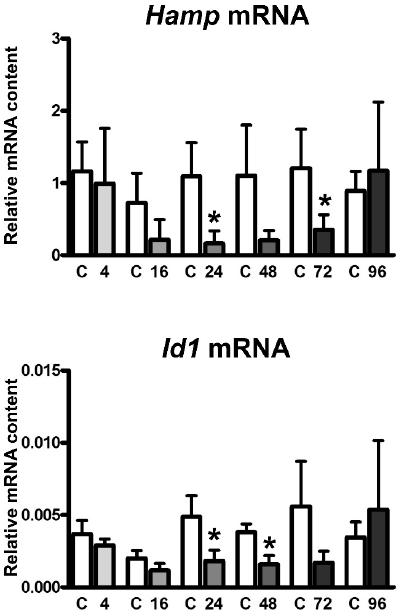
Figure 1. Single injection of EPO downregulates hepcidin expression at 16 h post injection. EPO was administered at 200 U/mouse and the relative expression of liver Hamp and Id1 was determined at the indicated time points in groups of three control mice (C) and three EPO-treated mice. Target mRNA content is expressed relative to Actb expression, * denotes statistical significance between EPO-treated group and the respective control group ( p < 0.05). Values were obtained from two independent experiments.